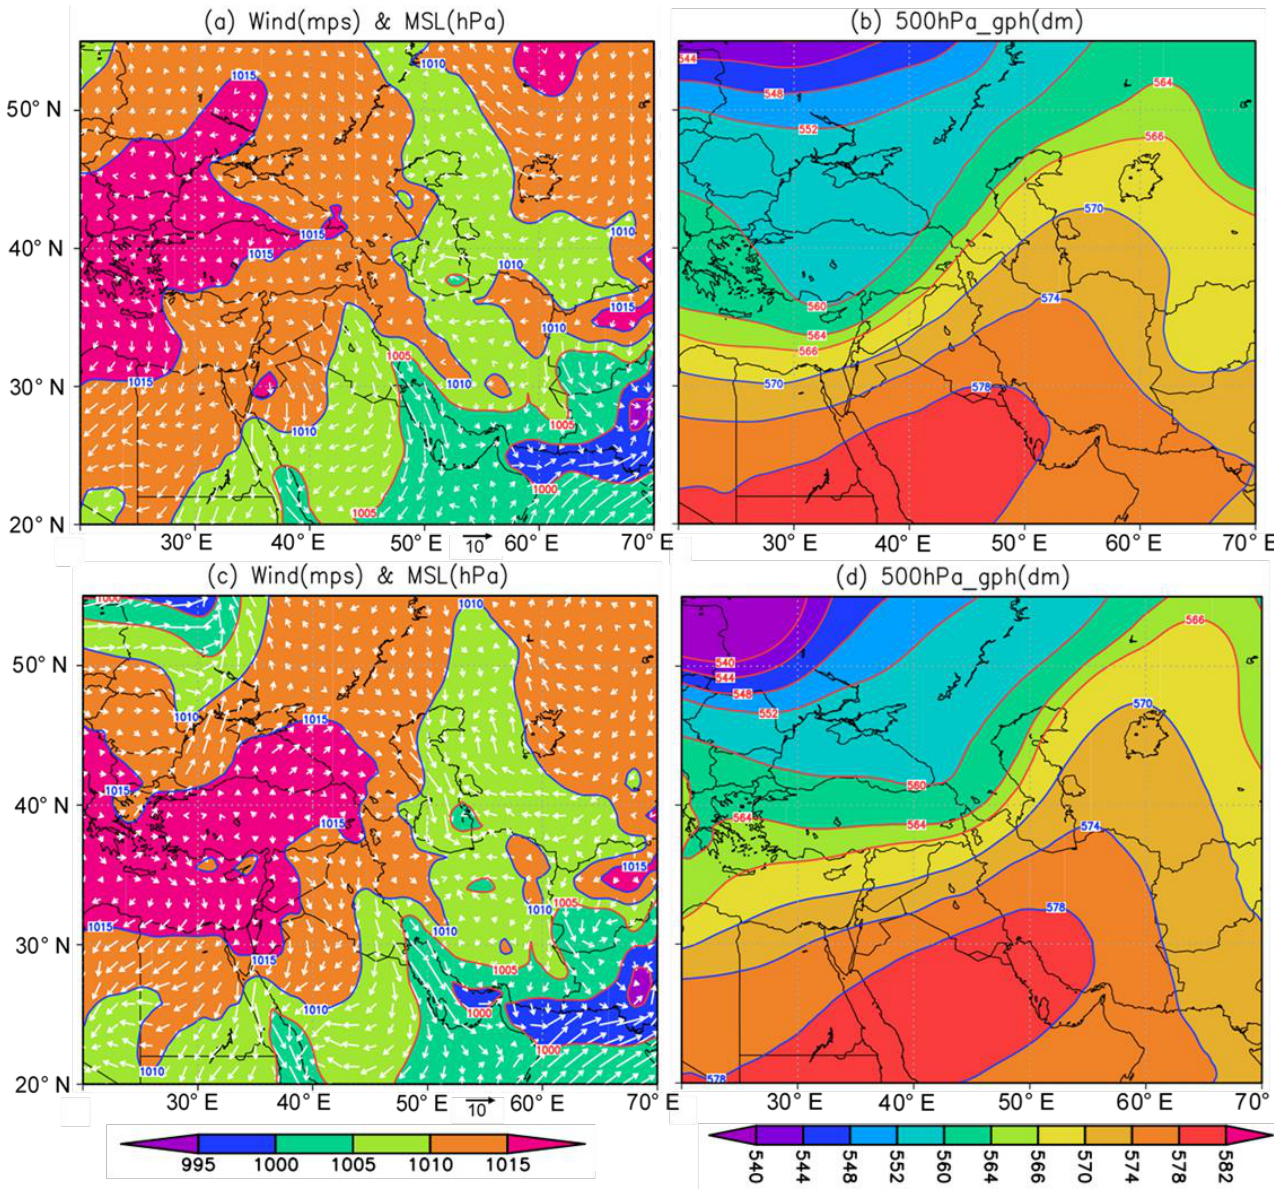
Figure 4. Sea level pressure (shaded as in the legend and solid color contours, interval is 5 mb), wind (ms −1 ), and 500-hPa geopotential height (shaded as in the legend and solid red and blue contours, interval is 4 dam) at 00UTC on 1 and 2 June 2012. ( a ) and ( b ) for 1 June 2012, ( c ) and ( d ) for 2 June 2012.